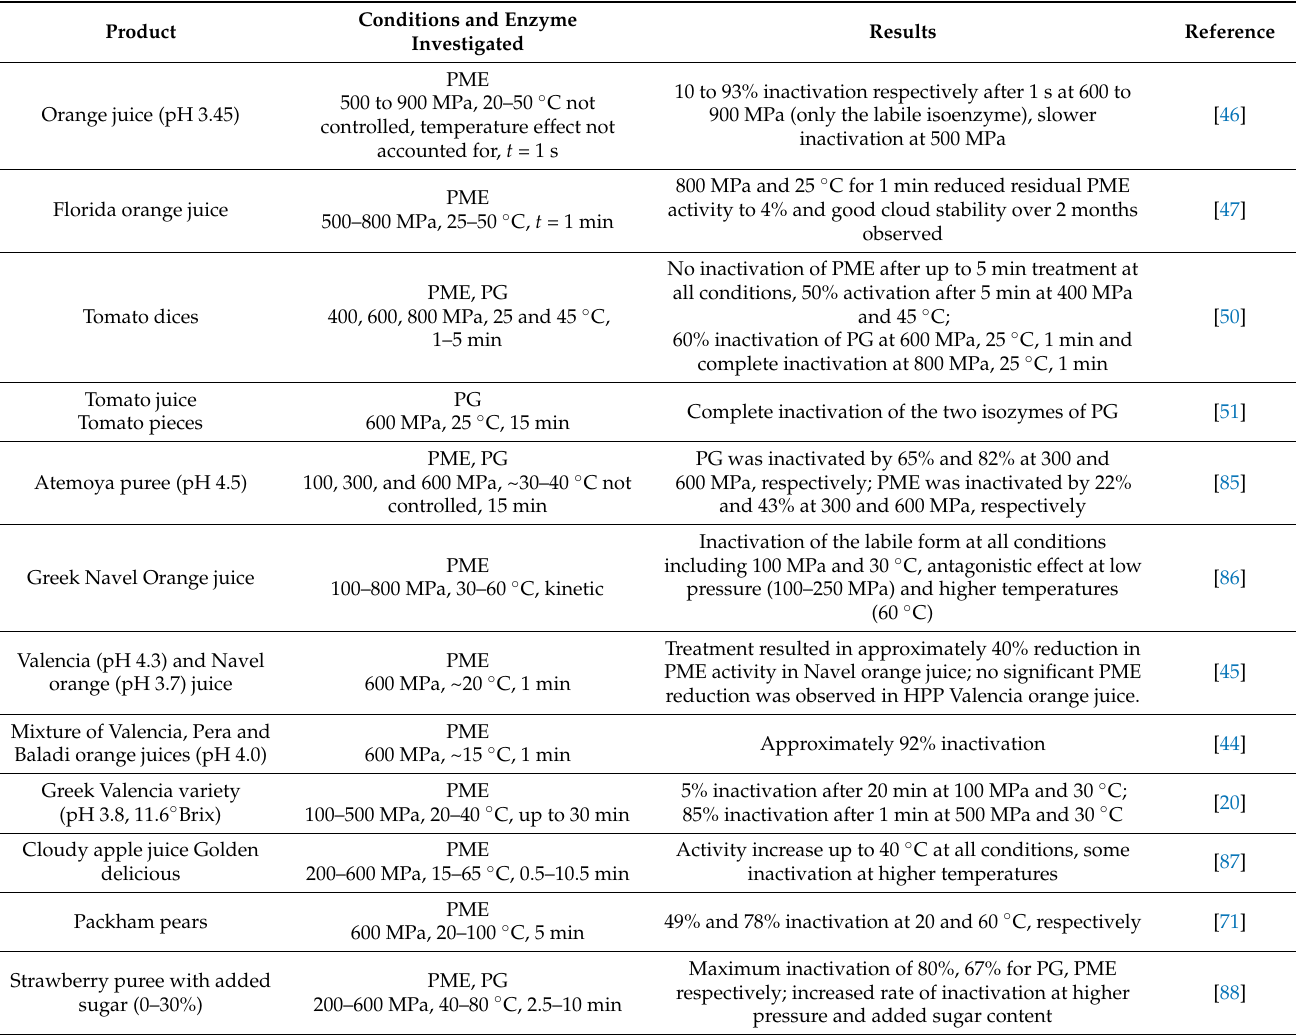
Table 3. Summary of relevant studies on the effect of HPP on pectin modifying enzymes in fruits and